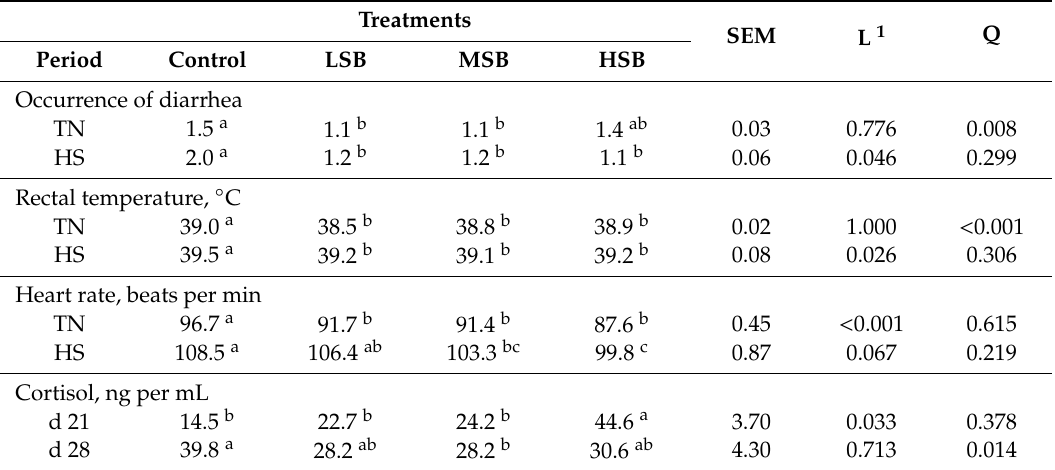
Table 3. Physiological parameters of diarrhea status, rectal temperature, heart rate, and cortisol level of calves receiving SB during the TN period (d 1 to 21) and HS period (d 22 to 28). Treatments